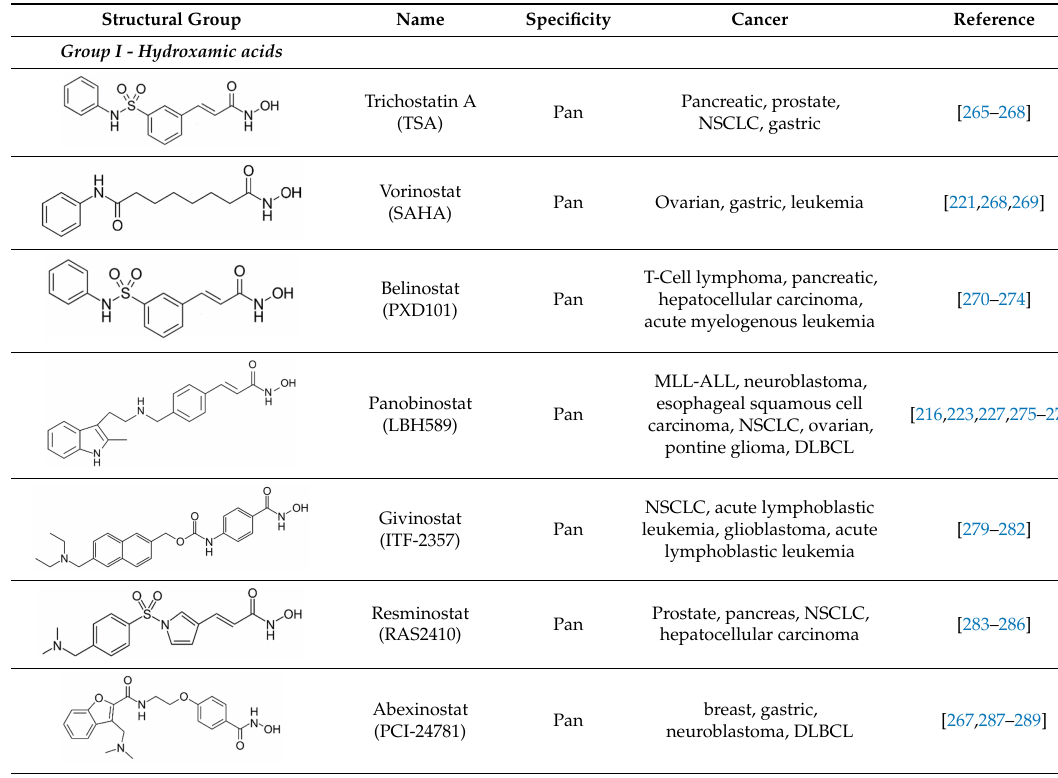
Table 3. List of HDAC inhibitors (HDACi). Columns indicate: structural class (as described in the text); name of the inhibitor (in brackets, alternative name); specificity of inhibition (‘Pan’ indicating an activity against all HDACs); cancer type in which the drug is currently being tested; references (with focus on drug tests in cancer contexts). The following drugs in this table have been approved by the Food & Drug Administration (FDA), as of May 2020: Vorinostat, Belinostat, Panobinostat, Valproic acid and